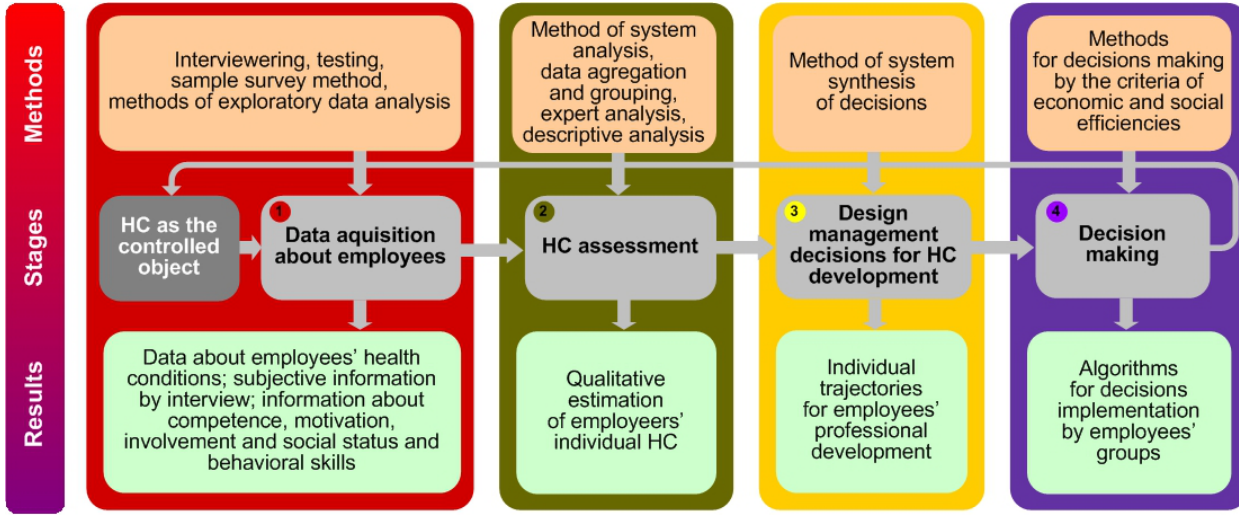
Figure 3. Conceptual scheme of the CHCM methodology.